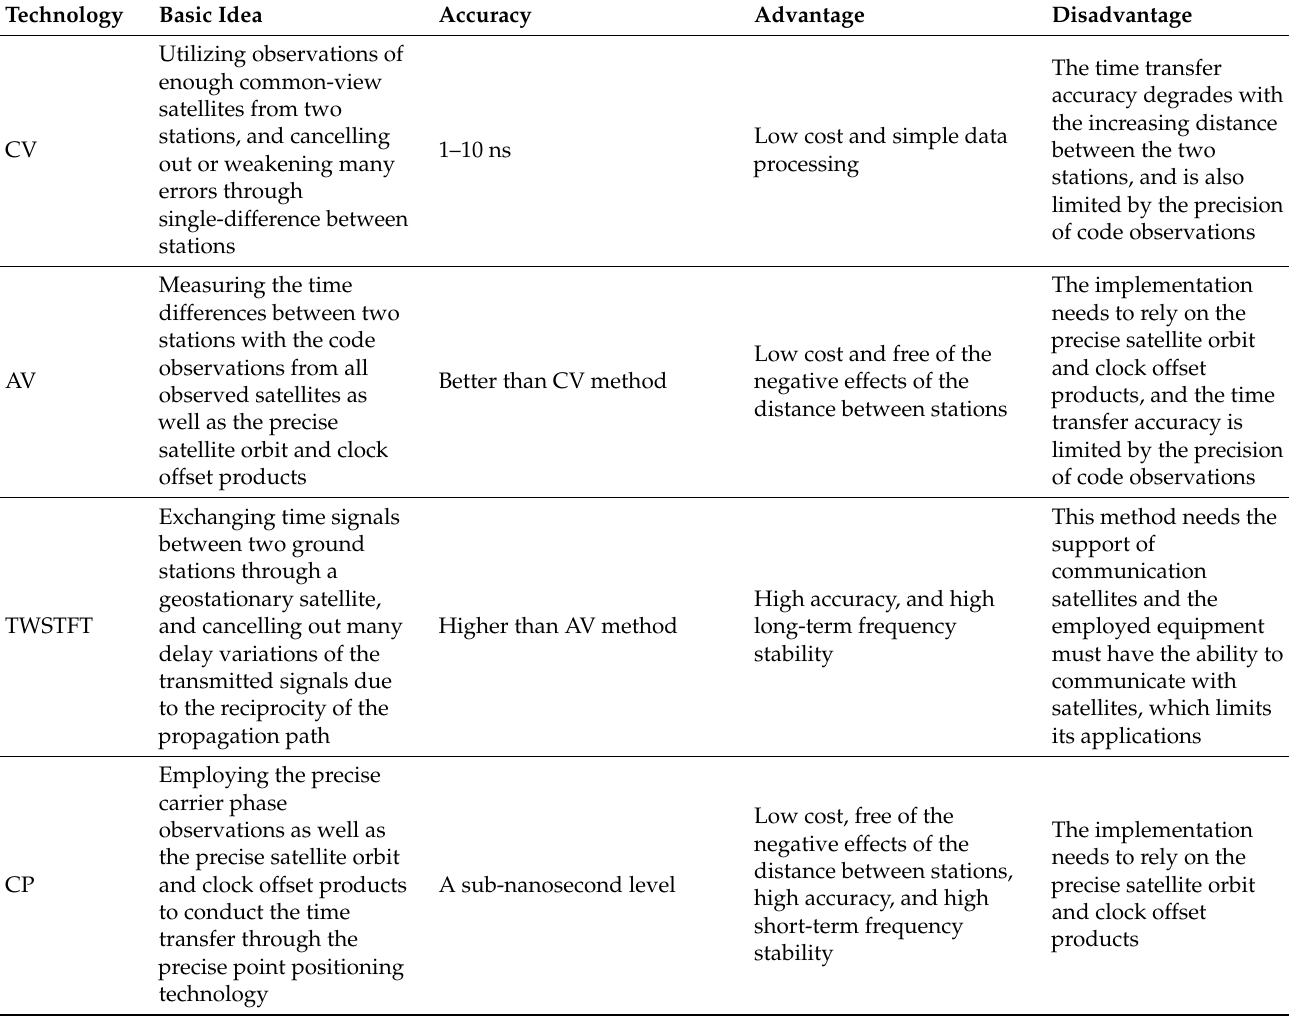
Table 1. Basic idea, advantage, and disadvantage of four typical GNSS time transfer